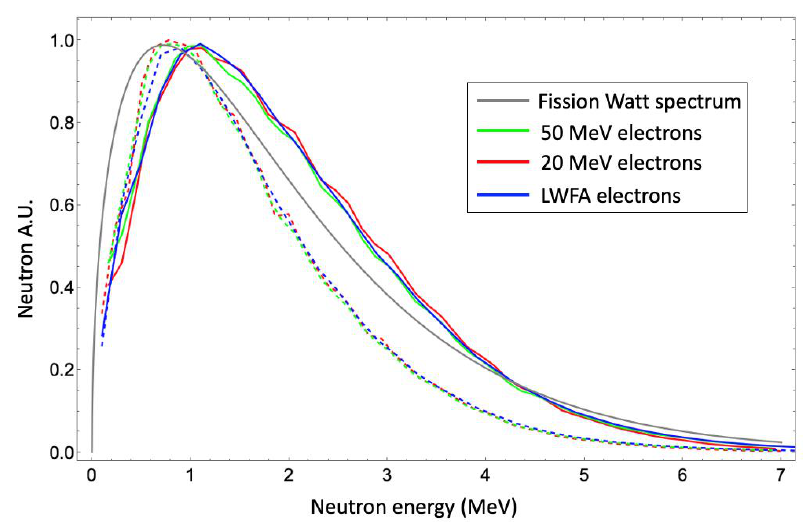
Figure 5. Neutron energy spectra for 20 MeV (red), 50 MeV (green) electron beams and LWFA electrons (blue) sampled at r = 0.5 cm (solid), r = 10 cm (dashed) and Watt fission spectrum (gray) for U-235.